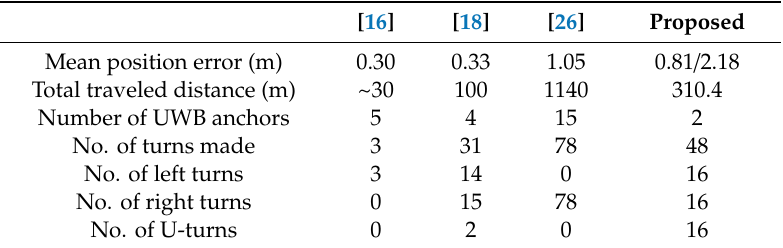
Table 4. Tracking performance